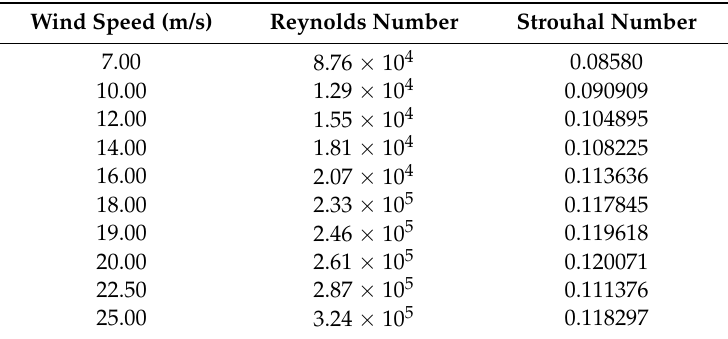
Table 3. Wind speed, Reynolds number and Strouhal number.